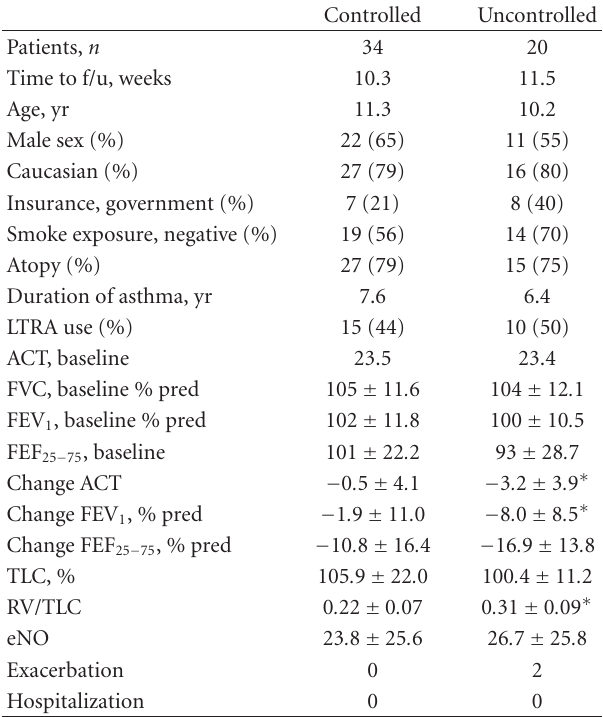
Table 2: Patient characteristics comparing those that maintained asthma control o ff LABA therapy at followup (controlled) and those that experienced loss of asthma control (uncontrolled). ∗ represents P < 0 .